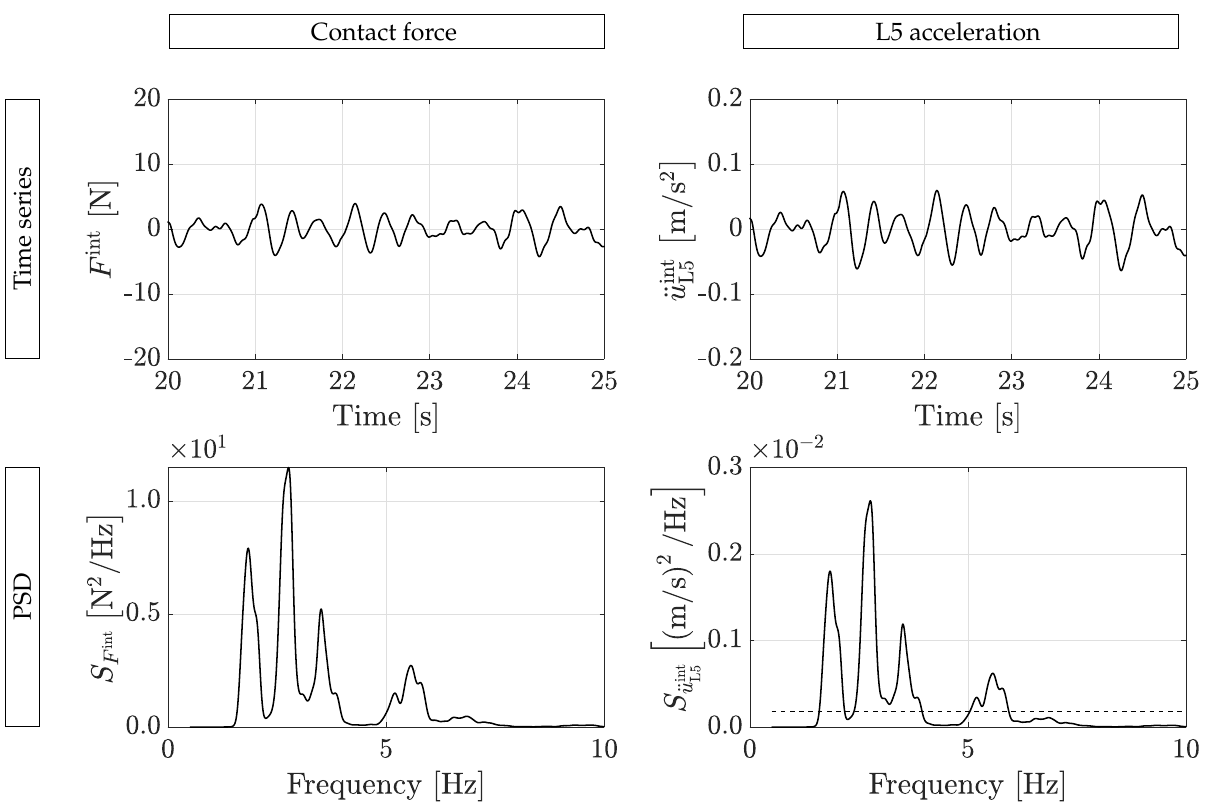
Figure 16. The interaction contact force and interaction L5 acceleration of a representative participant: time series and PSD (solid line) with an indication of the measurement noise or the low-cost sensors (dashed